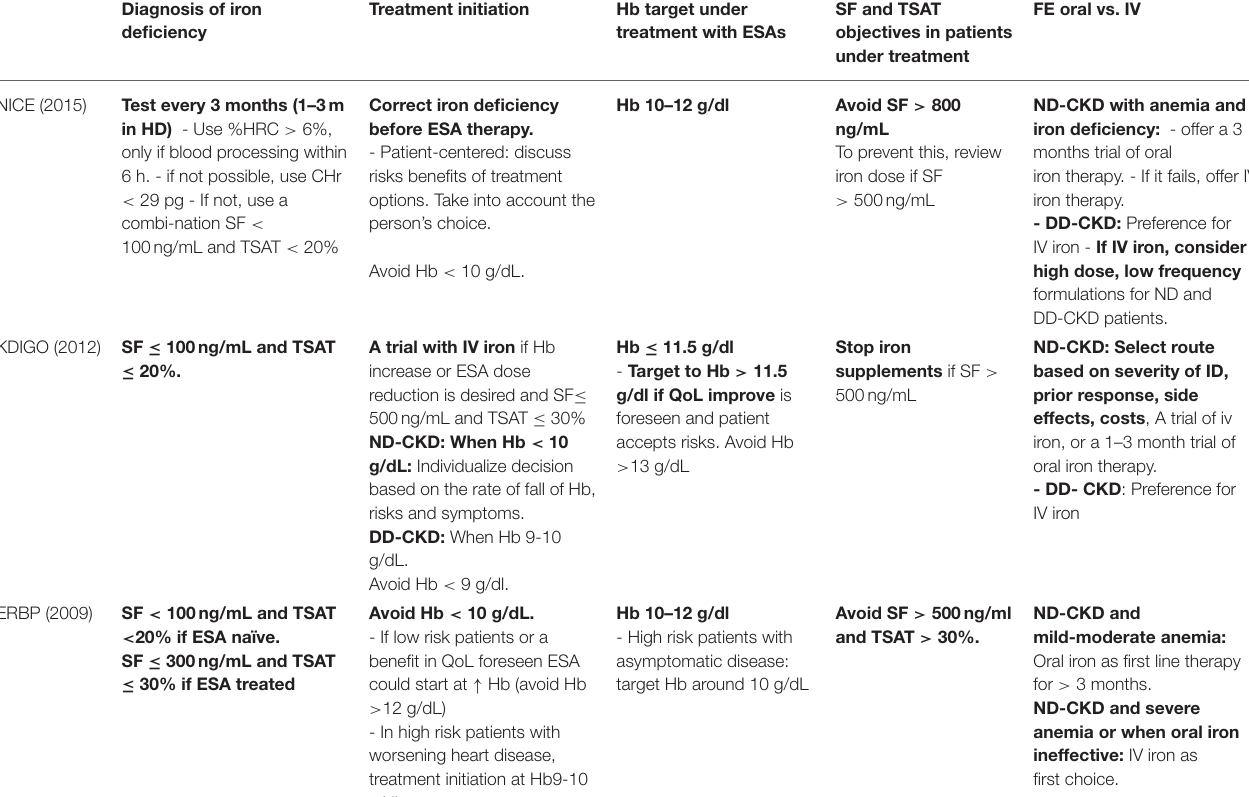
TABLE 1 | Summary of the key recommendations of the most recent anemia guidelines. Diagnosis of iron Treatment initiation Hb target under deficiency treatment with